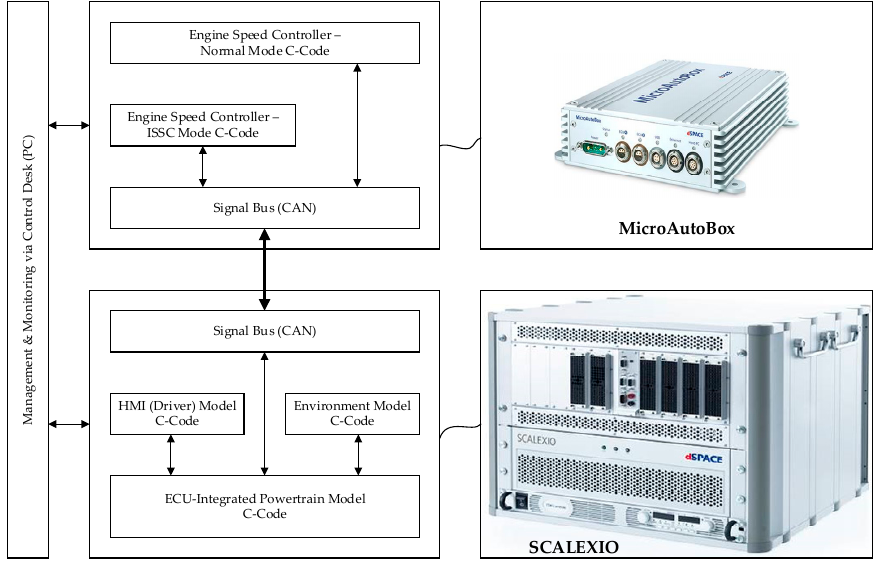
Figure 5. Structure of the HIL system.